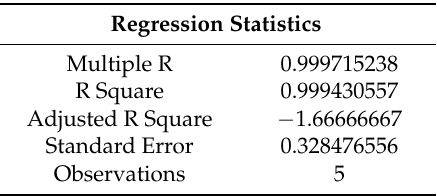
Table 3. Regression Statistics.